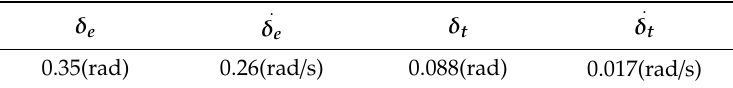
Table 3. The maximum deflections and